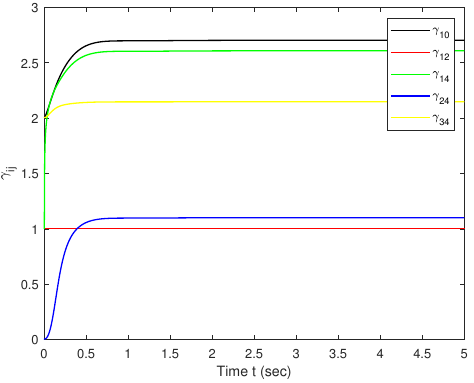
Figure 3. Dynamic observer gain γ ij , i = 1,2,3,4, j ∈ ¯ N i .